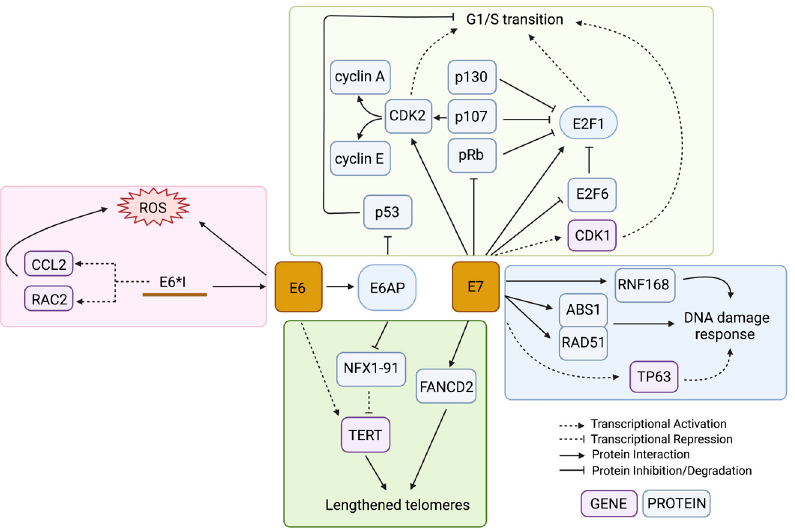
Figure 3. Mechanisms in which E6 and E7 lead to genome instability. The HPV oncoproteins E6 and E7 dysregulate several pathways at both the gene and protein level as a way to increase genome instability in the infected cell, including the cell cycle transition (yellow box), DDR pathways (blue box), generation of oxidative stress (red box), and telomere length alterations (green box). The colour of the box containing the gene name indicates if it is being regulated at the gene or protein level. Created with BioRender.com.